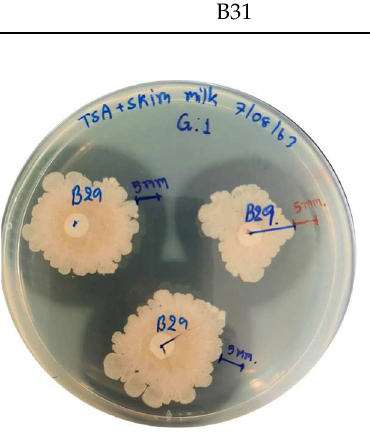
Figure 4. Protease-producing capacity of Bacillus isolate B29 on skim milk agar.